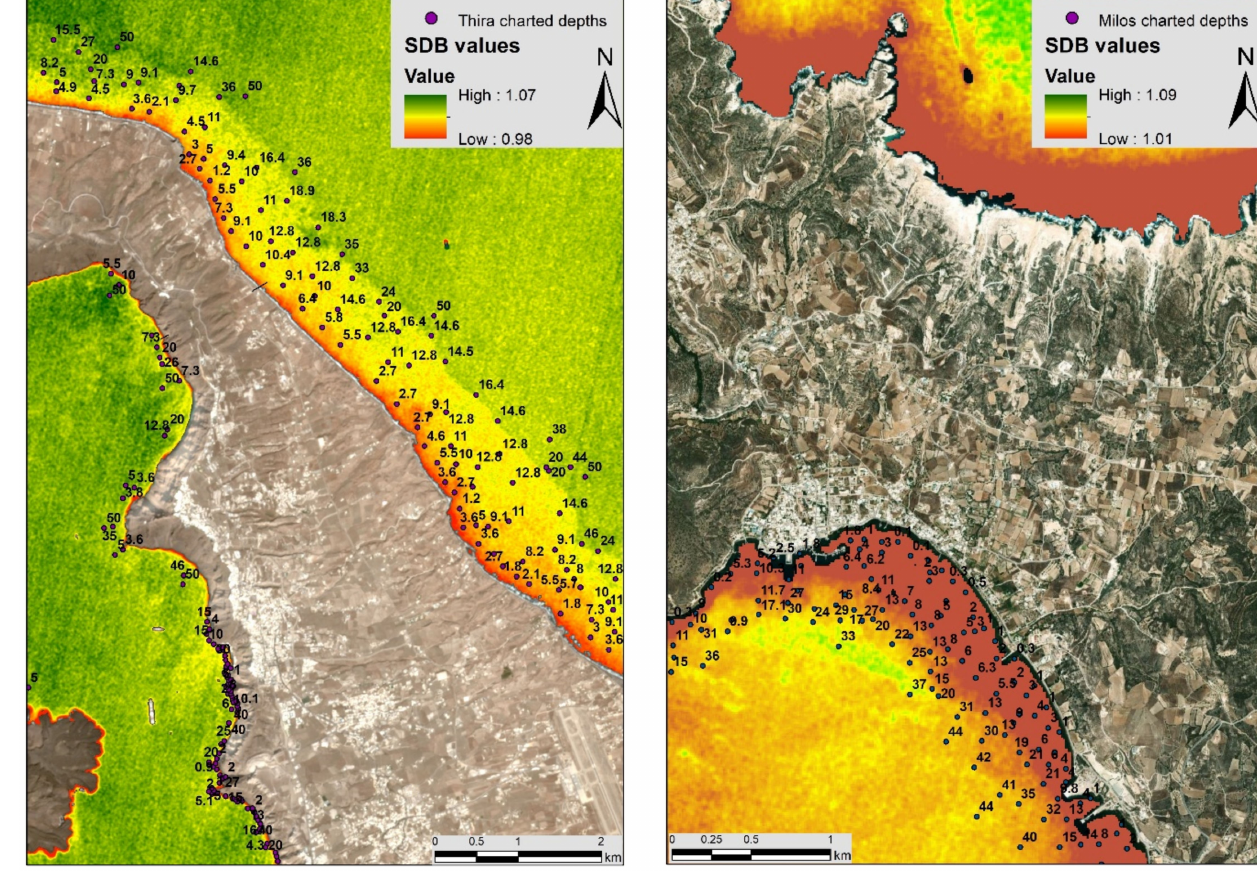
Figure 10. SDB algorithm’s results focused on the northern part of Thira ( left image ) and centre part Milos ( right image ) using the developed semi-automatic script. Red areas represent shallower depths, in contrast to yellow–green areas that illustrate deeper regions.